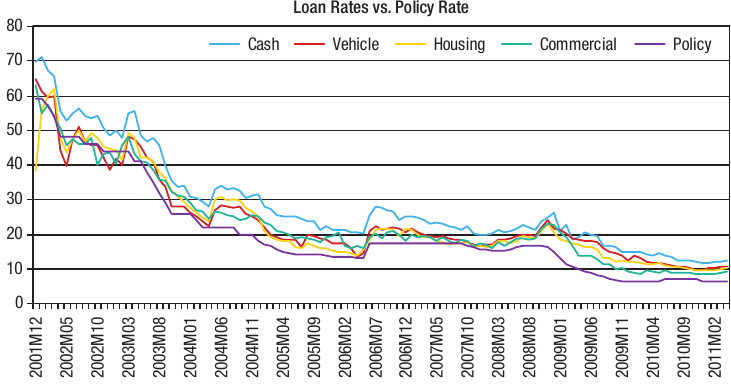
Loan Rates vs.Policy